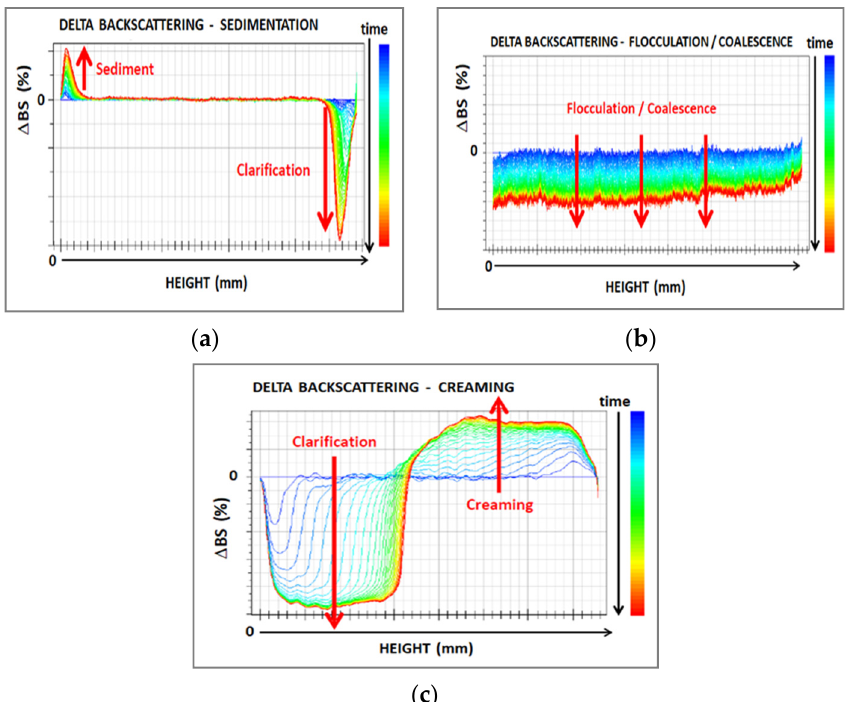
Figure 1. Main phenomena of destabilization in dispersions observed by Turbiscan analysis: ( a ) sedimentation; ( b ) flocculation/coalescence; and ( c ) creaming. (adapted from [16]) .